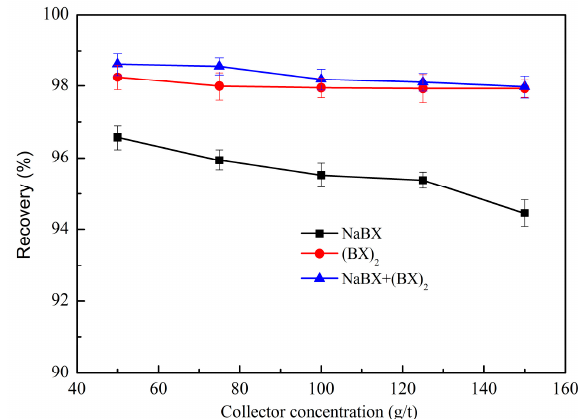
Figure 3. Flotation recoveries of magnetite with individual collector NaBX, (BX) 2 and mixed collector = 3:2) as a function of collector concentration (NaSiF 6 500 g/t, pine oil 46 g/t, pH = (m (cid:2898)(cid:2911)(cid:2886)(cid:2908) :m ((cid:2886)(cid:2908)) (cid:3118)